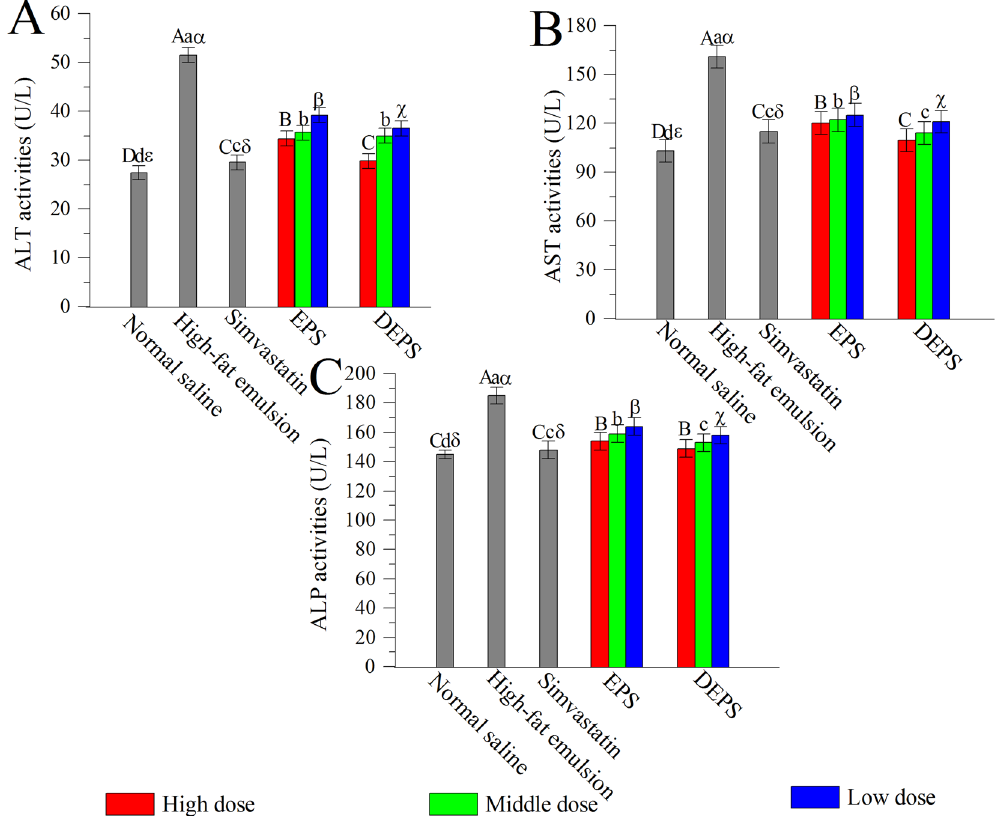
Figure 4. Effects of EPS and DEPS on the serum ALT ( A ), AST ( B ) and ALP ( C ) activities. The values are reported as means ± SD (n = 10). Bars with different letters are significantly different ( P <